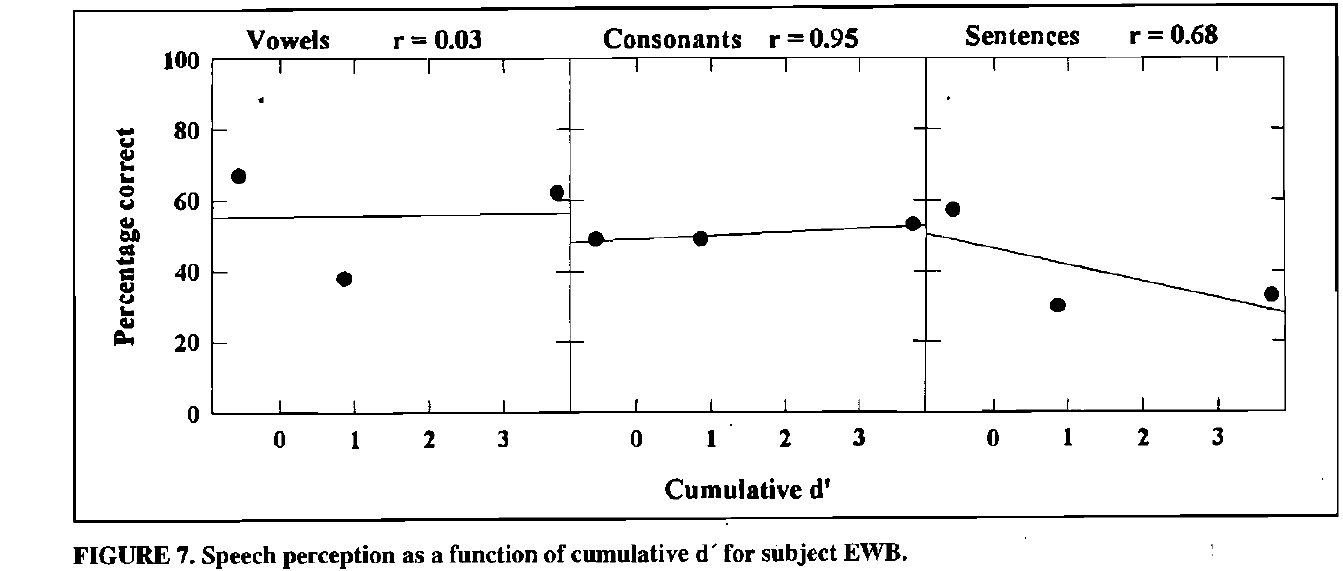
FIGURE 7. Speech perception as a function of cumulative d' for subject